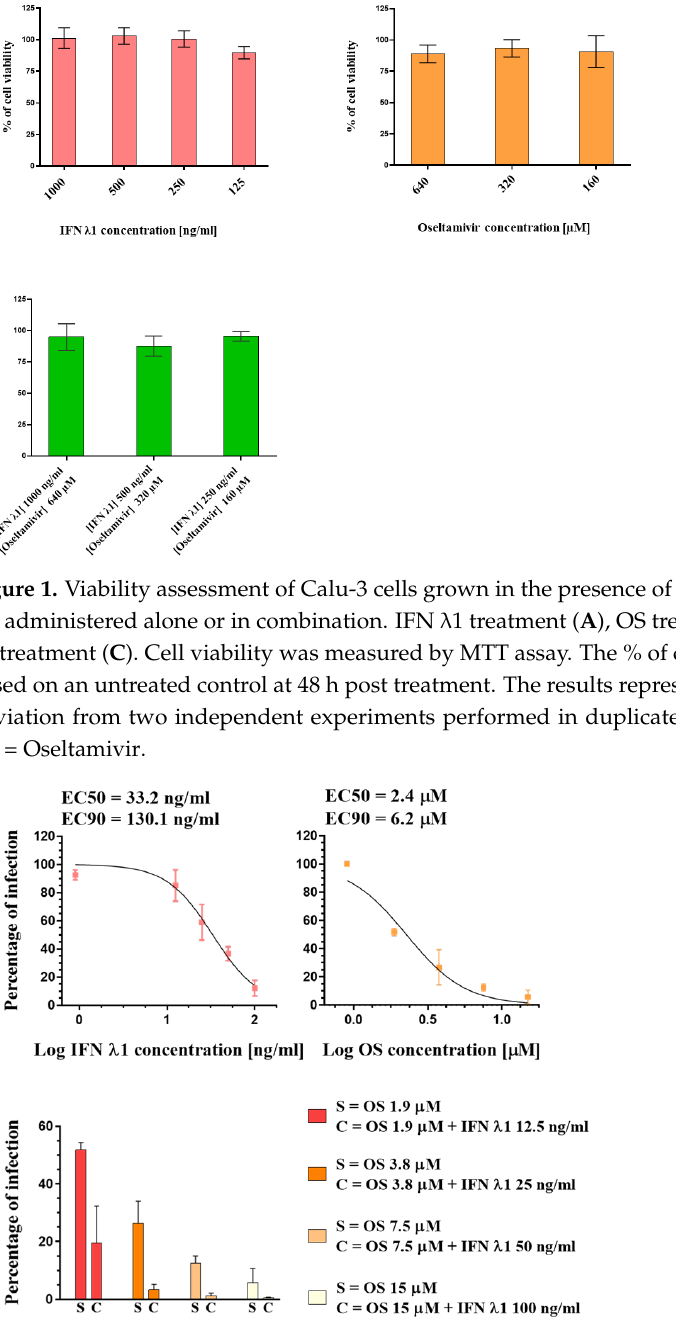
Figure 2. Comparison of IFN λ1 and OS antiviral activity against A(H1N1)pdm09 in Calu-3 cells. ( A ) Dose–response curve of the single treatments. The percentages of infection represent the number of plaques induced by infectious supernatant collected at 24 hpi, in treated versus untreated controls. The infection was performed with a MOI of 0.1 PFU/cell. EC50 = Half maximal effective concentration; EC90 = drug concentration at which 90% of the maximal effect is observed. ( B ) Bar plot showing the percentages of infection (determined as in A) of a dose range of OS administered individually (S) or of a dose range of OS administered together with a dose range of IFN λ1 (C). The results represent the mean and standard deviation from two independent experiments performed in duplicate.